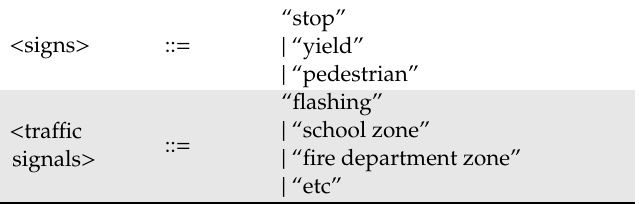
Table A8. The 4th stage of < environment >< objects >< signage > .